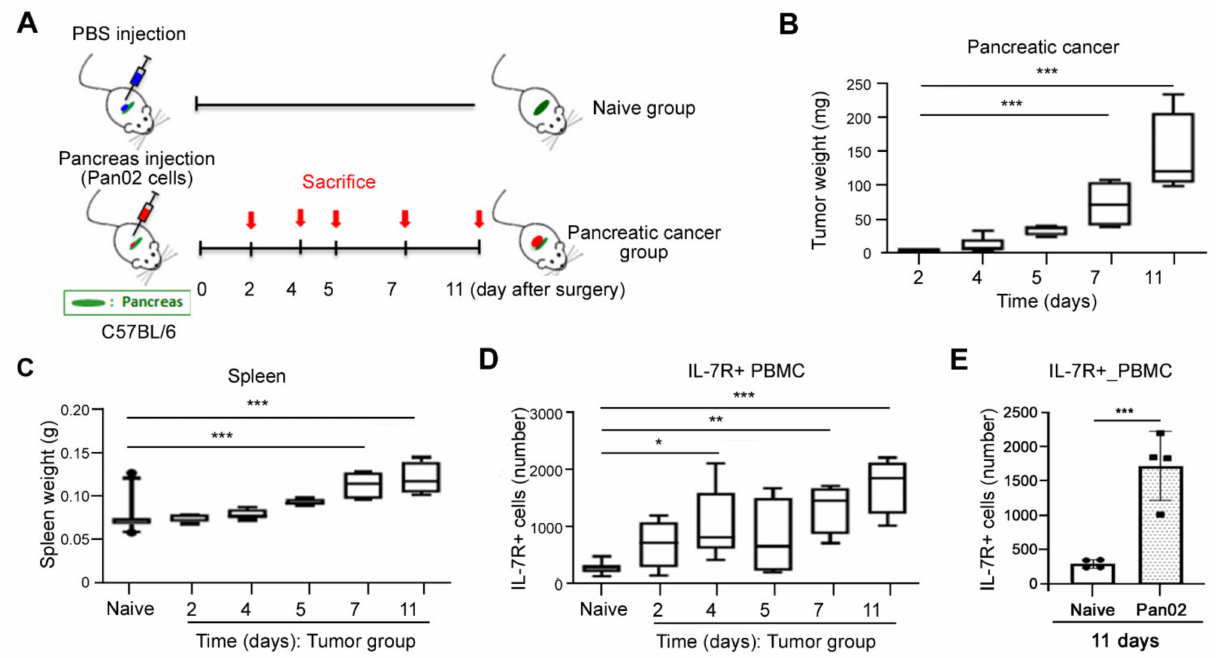
Figure 2. Elevation of IL-7Ra expressing cells during early tumorigenesis in vivo. ( A ) Schematic illustration of an orthotopic syngeneic pancreatic cancer murine model. Pan02 cells were transplanted into pancreas. Four mouse bearing pancreatic cancer per group were sacrificed after 2, 4, 5, 7, 11 days. Mice injected with PBS was used as a naive control (N = 15). ( B , C ) On the day of sacrifice, tumors ( B ) and spleens ( C ) were removed and weighted in syngeneic mouse model. *** p < 0.001 versus day 2 ( B ) or naive control ( C ). ( D ) The number of IL-7R expressing cells were determined from mouse PBMC during tumorigenesis in vivo. * p < 0.05, ** p < 0.005, or *** p < 0.001 versus naive control. ( E ) IL-7R expression in PBMC was analyzed from naive or tumor bearing mice after 11 days of Pan02